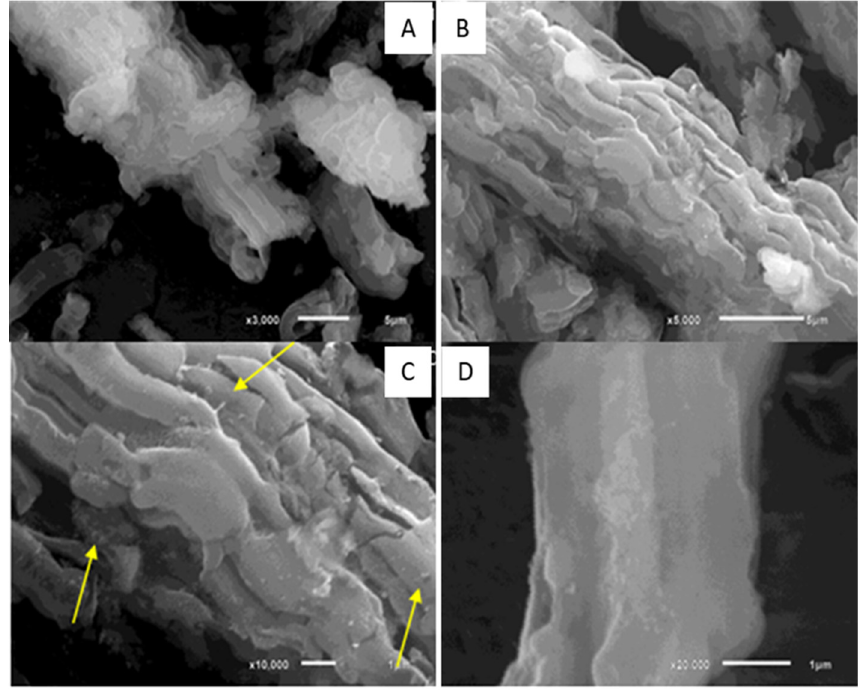
Figure 2. Scanning Electron Microscopy images of the SBA-15/HAP_1 aggregate ( A , B ). The yellow arrows ( C ) show the HAP crystals on the mesoporous silica surface, In ( D ) is possible to observe the HAP using a augmented vision (X20.000).